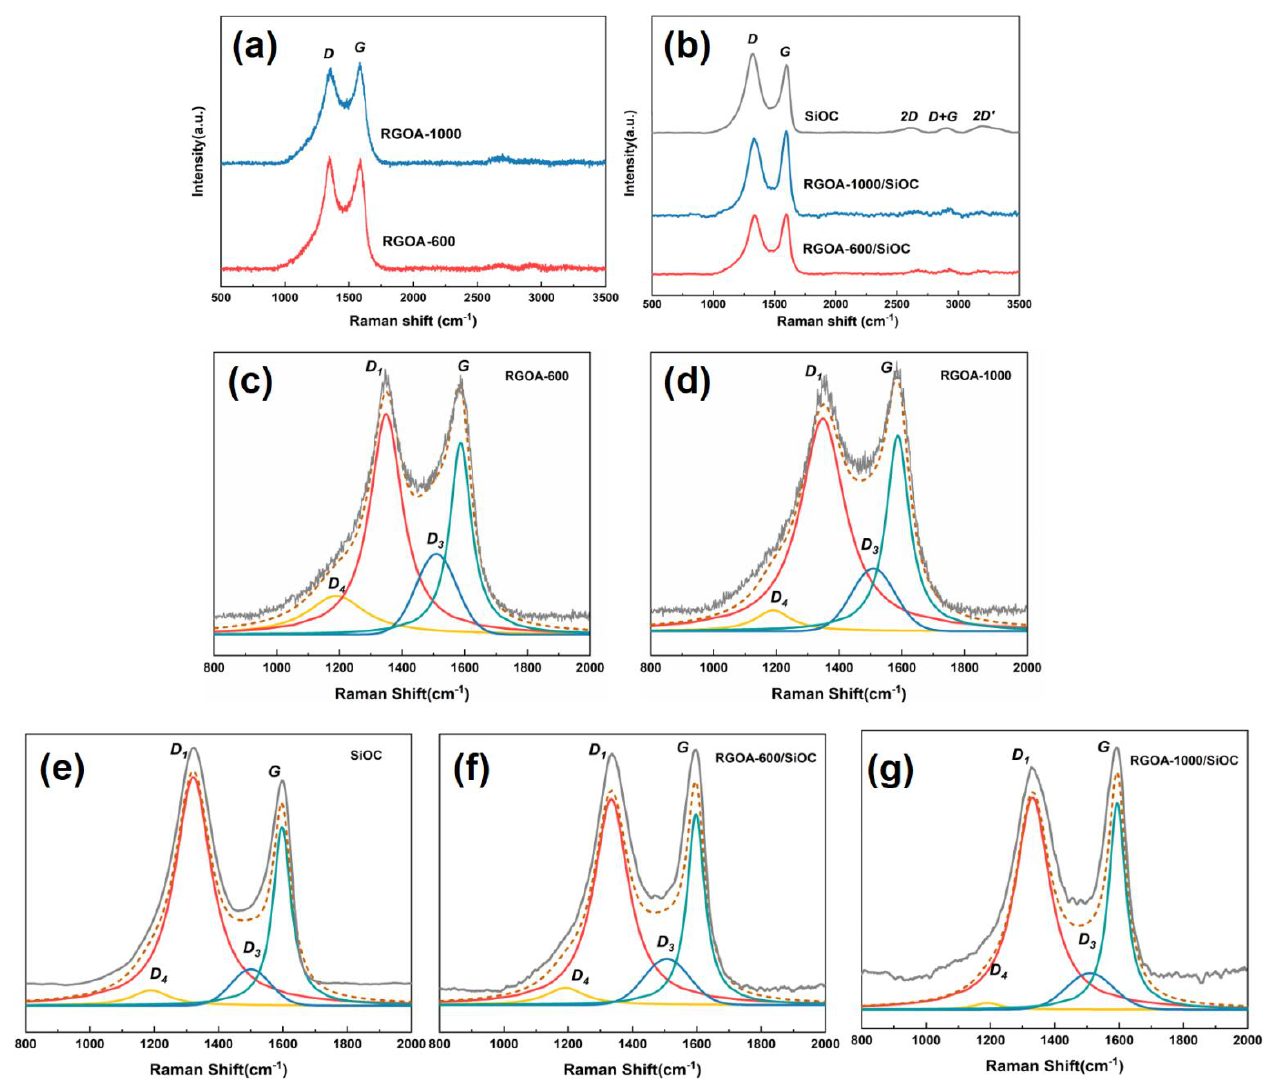
Figure 4. Raman spectra of ( a ) RGOA-600 and RGOA-1000 and ( b ) RGOA modified SiOC nanocom- posites and SiOC. ( c – g ) Deconvoluted spectra of RGOA-600, RGOA-1000, SiOC, RGOA-600/SiOC, and RGOA-1000/SiOC, respectively. The experimental spectra are shown by the solid grey line on top, followed by the simulated spectra (dashed brown lines), and the individual simulation components (solid colored lines). Table 1. Band positions, intensity ratios I(D1)/I(G) obtained from curve fitting of the Raman spectra, and lateral crystallite sizes of free carbon of the SiOC, RGOA-600 and -1000, and RGOA-600 and -1000/SiOC samples.